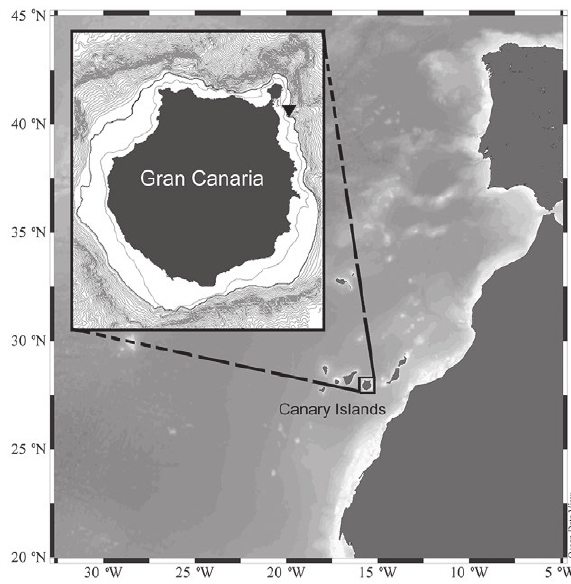
Fig. 1. – Study area in the NE Atlantic, showing the location of the sampling station (black triangle) near the island of Gran